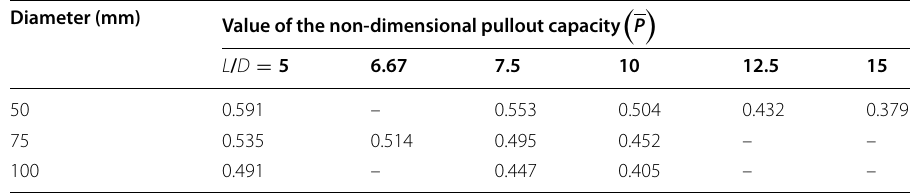
Table 12 Variation of the non-dimensional pullout capacity (cid:31) P (cid:30) Diameter (mm)